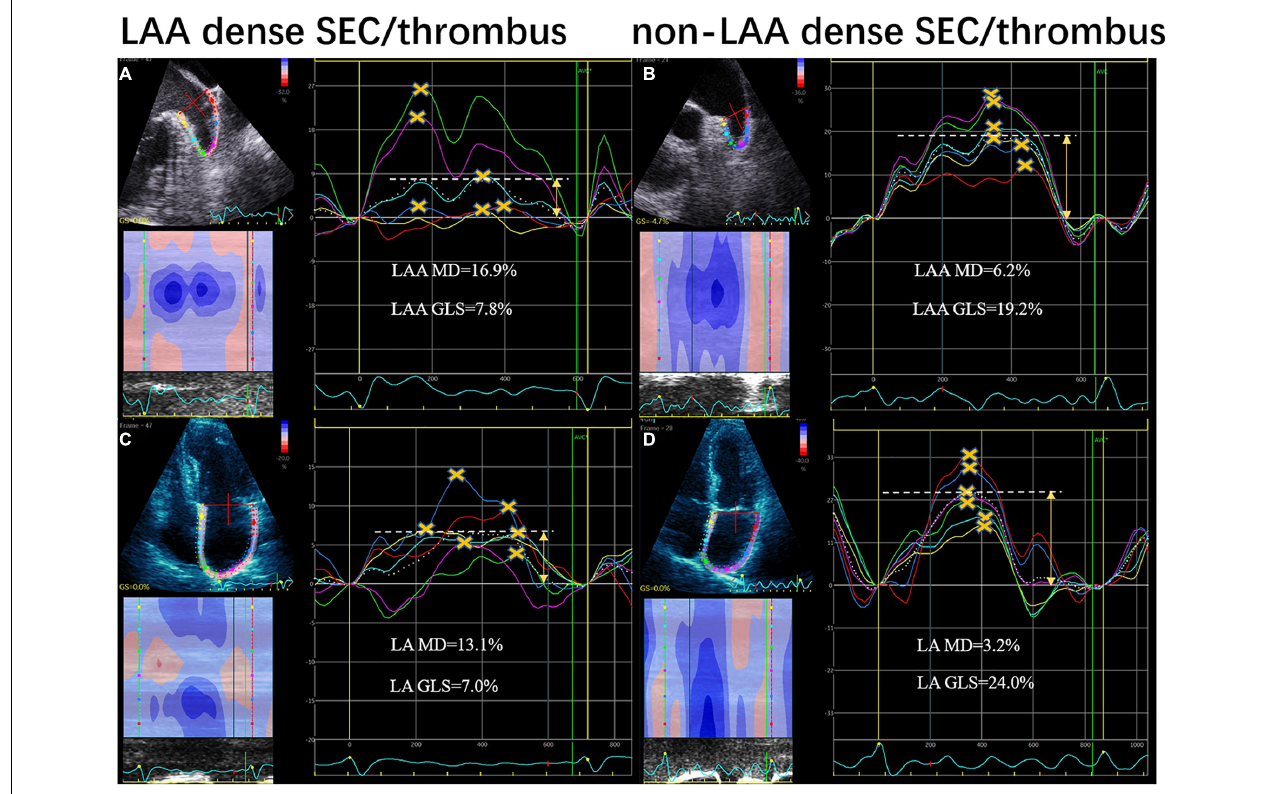
FIGURE 1 | LAA and LA strain curves from speckle-tracking in patients with LAA dense spontaneous echo contrast and thrombus (A,C) and controls (B,D) . Yellow crosses indicate the positive peaks of each curve. Yellow arrows indicate the global peak longitudinal strain (GLS). Mechanical dispersion (MD) was defined as the SD of time to peak and expressed as a percentage of the R-R interval. LA, left atrium; LAA, left atrial appendage.